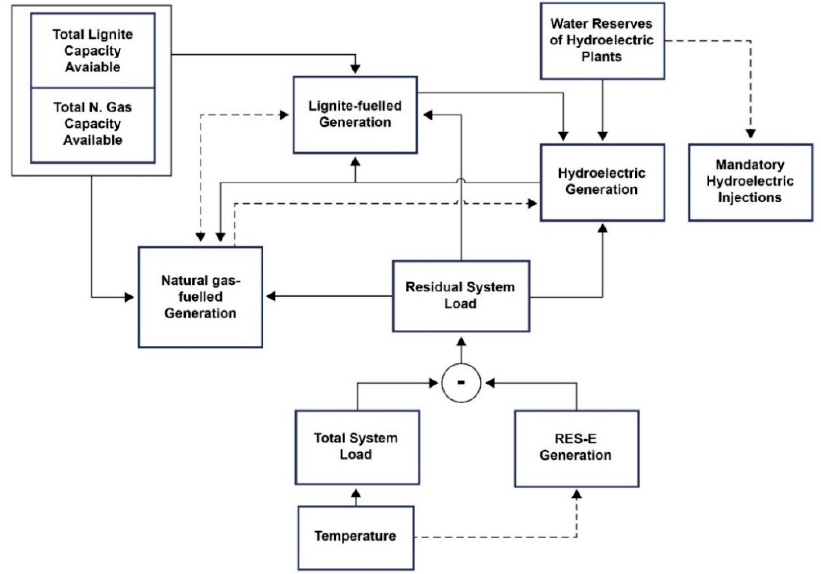
Figure 3. Causal relationships within the wholesale electricity market in Greece during the period 2009 to